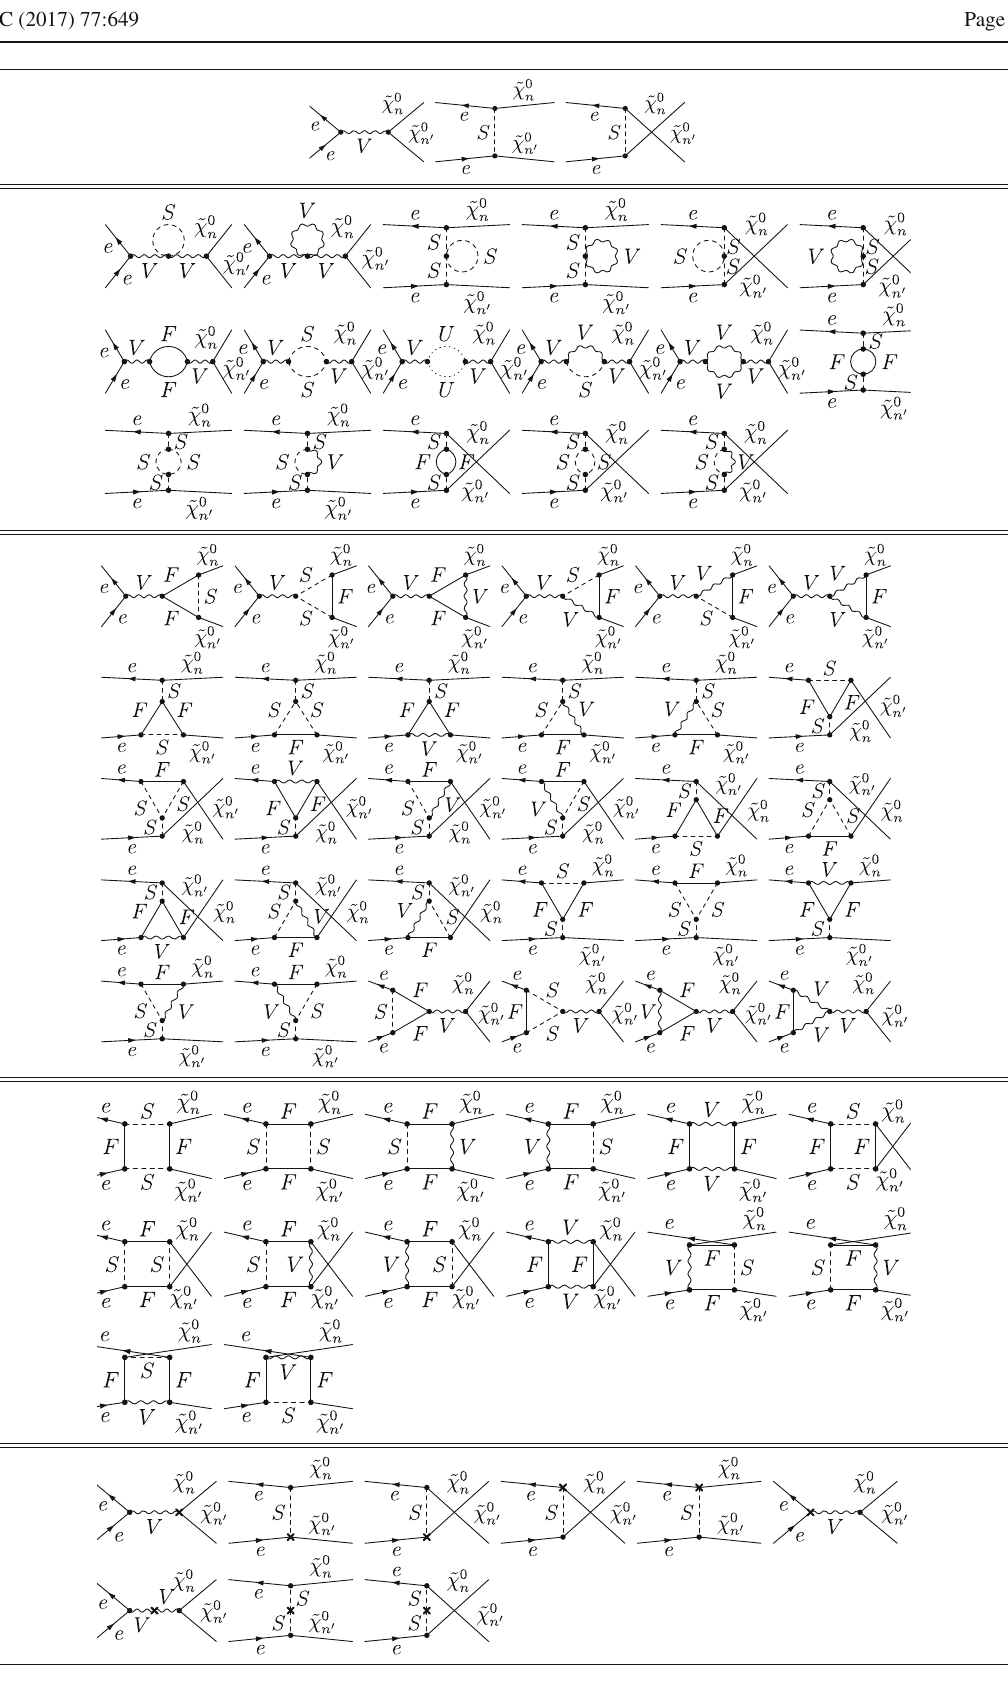
( n , n (cid:4) = 1 , 2 , 3 , n (cid:4)